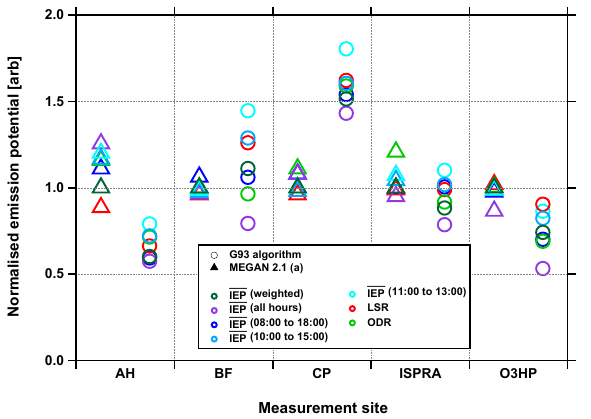
Figure 3. Isoprene emission potentials (normalised to the MEGAN 2.1 weighted average emission potential) calculated for Alice Holt (AH), Bosco Fontana (BF), Ispra forest (ISPRA) and the Observatoire de Haute Provence (O3HP). Open circles show emis- sion potentials calculated using the G93 algorithm, and closed trian- gles show emission potentials calculated using the MEGAN model with method (a). For each algorithm, several different approaches were used to work back to an emission